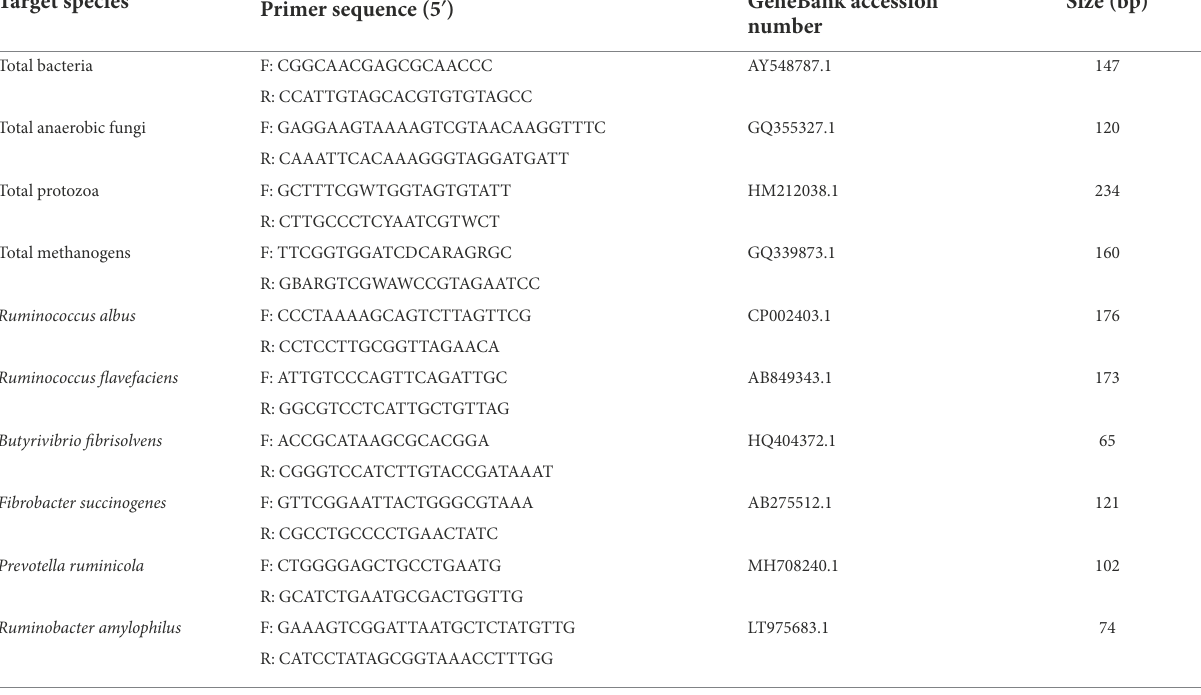
TABLE 2 PCR primers for real-time PCR assay.